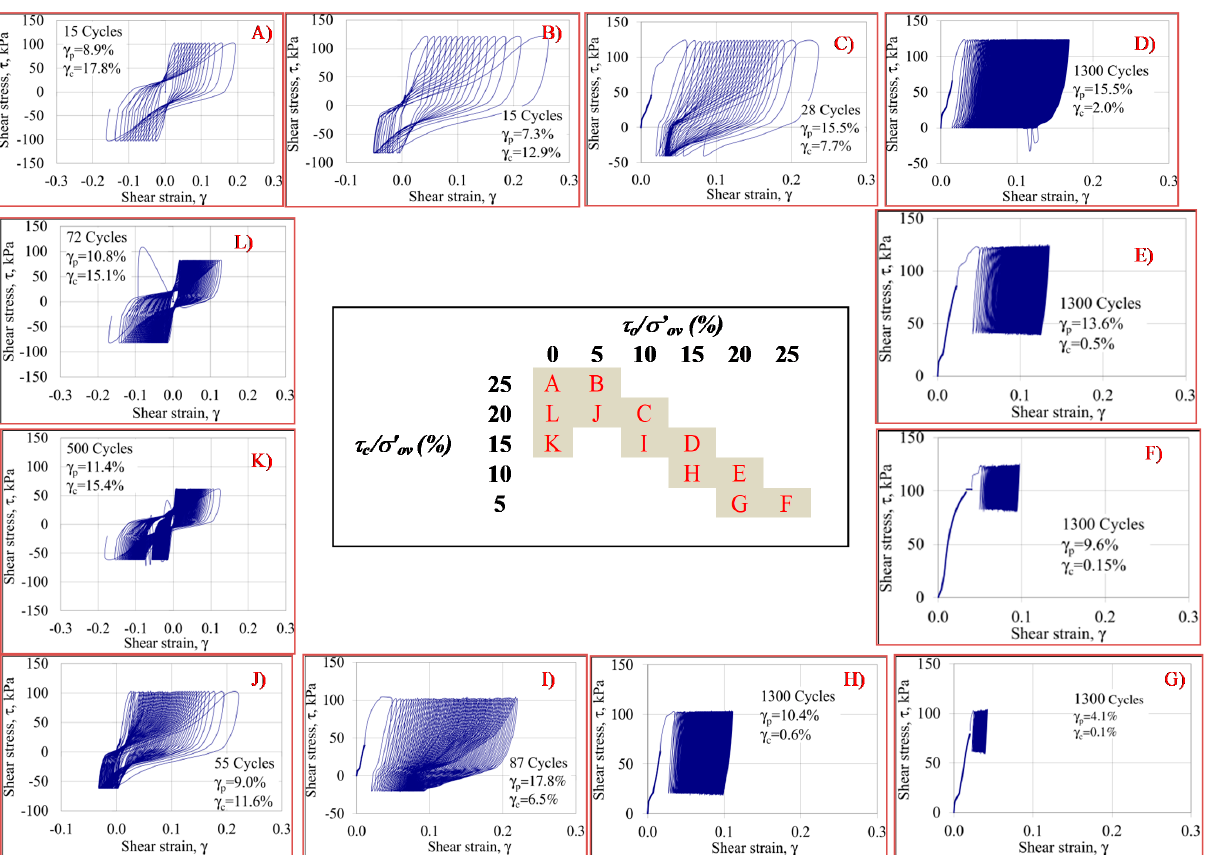
Figure 9. Comparison of typical stress-strain behavior for different combinations of normalized initial monotonic shear stress and different normalized cyclic shear stress. The results correspond to the tests performed with sample S1A-10 indicated in Table 1. ( A ) τ o / σ′ ov = 0% and τ c / σ′ ov = 25% ; ( B ) τ o / σ′ ov = 5% and τ c / σ′ ov = 25% ; ( C ) τ o / σ′ ov = 10% and τ c / σ′ ov = 20% ; ( D ) τ o / σ′ ov = 15% and τ c / σ′ ov = 15% ; ( E ) τ o / σ′ ov = 20% and τ c / σ′ ov = 10% ; ( F ) τ o / σ′ ov = 25% and τ c / σ′ ov = 5% ; ( G ) τ o / σ′ ov = 20% and τ c / σ′ ov = 5% ; ( H ) τ o / σ′ ov = 15% and τ c / σ′ ov = 10% ; ( I ) τ o / σ′ ov = 10% and τ c / σ′ ov = 15% ; ( J ) τ o / σ′ ov = 5% and τ c / σ′ ov = 20% ; ( K ) τ o / σ′ ov = 0% and τ c / σ′ ov = 15% ; ( L ) τ o / σ′ ov = 0% and τ c / σ′ ov = 20%.